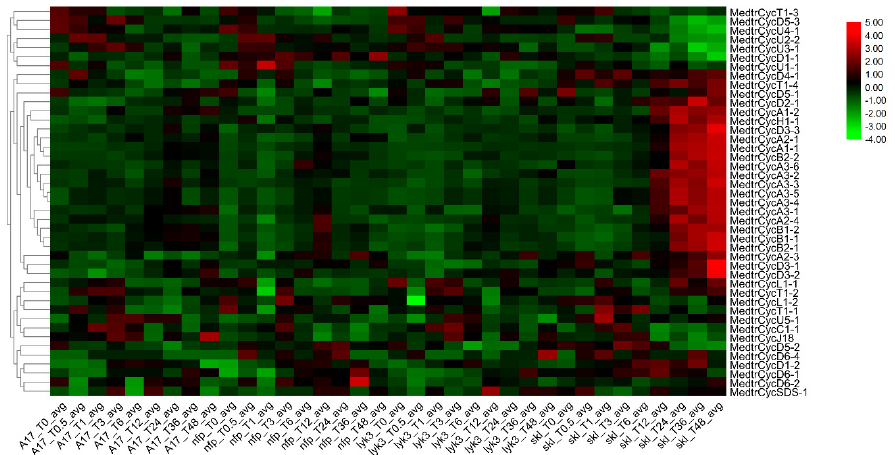
Figure 5. Heatmap of expression for Mtcyclins under rhizobium infection. The genome-wide RNA-seq data of M. truncatula were obtained from the Query genes expression website. The expression data of cyclins in wild-type (WT) A17, mutants with absent or decreased nodulation (Nod) factor sensitivities (i.e., nodulation factor perception ( nfp ) and lysine motif domain-containing receptor-like kinase 3 ( lyk3 ), respectively) and the Nod factor-hypersensitive mutant (sickle, skl ). This data set encompasses nine time points, allowing observation of the symbiotic regulation of diverse biological processes with high temporal